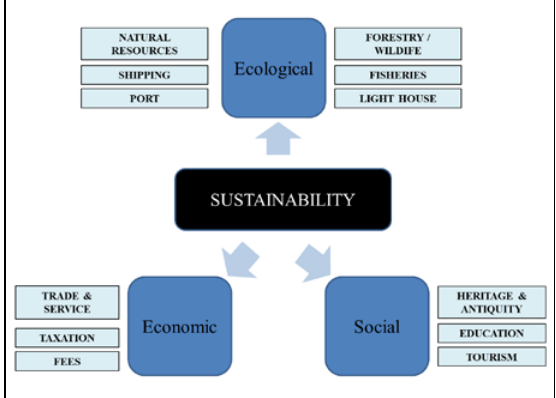
Figure 5. Institutional Sustainability according to Marine Government